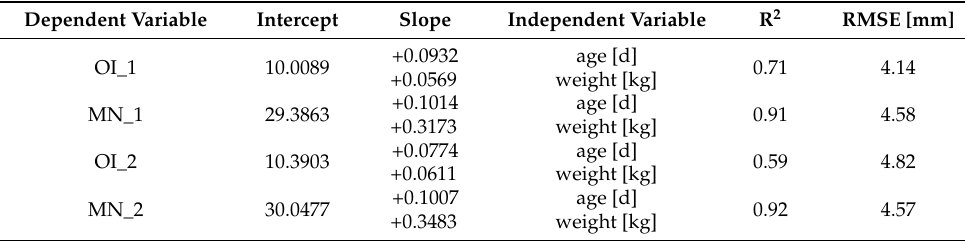
Table 4. Results of the stepwise regression analysis for all observations.